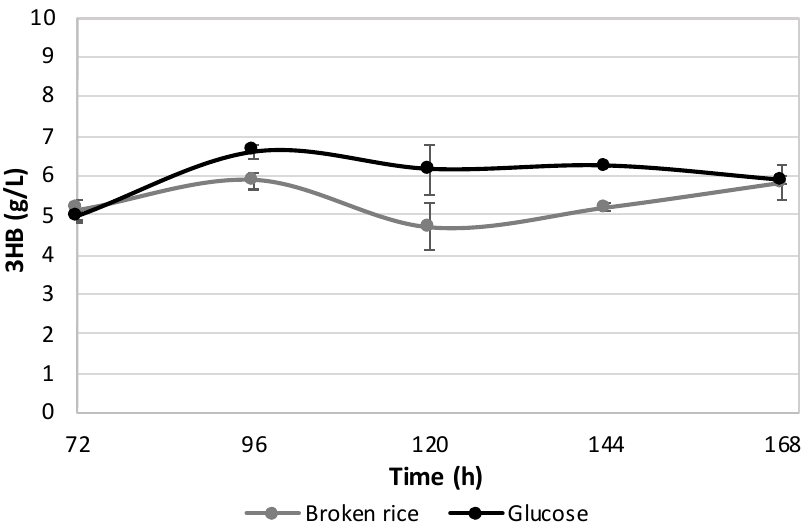
Figure 4. Levels (g / L) of 3HB from 3% broken rice under the SSF regime using the medium dosage of Figure 4. Levels (g/L) of 3HB from 3% broken rice under the SSF regime using the medium dosage of STARGEN ™ 002 (1.42 µ L per g of starch). An experiment with glucose as a carbon source was included STARGEN™ 002 (1.42 μ L per g of starch). An experiment with glucose as a carbon source was for comparison. The values represent the means of three replicates ± included for comparison. The values represent the means of three replicates ± SD.